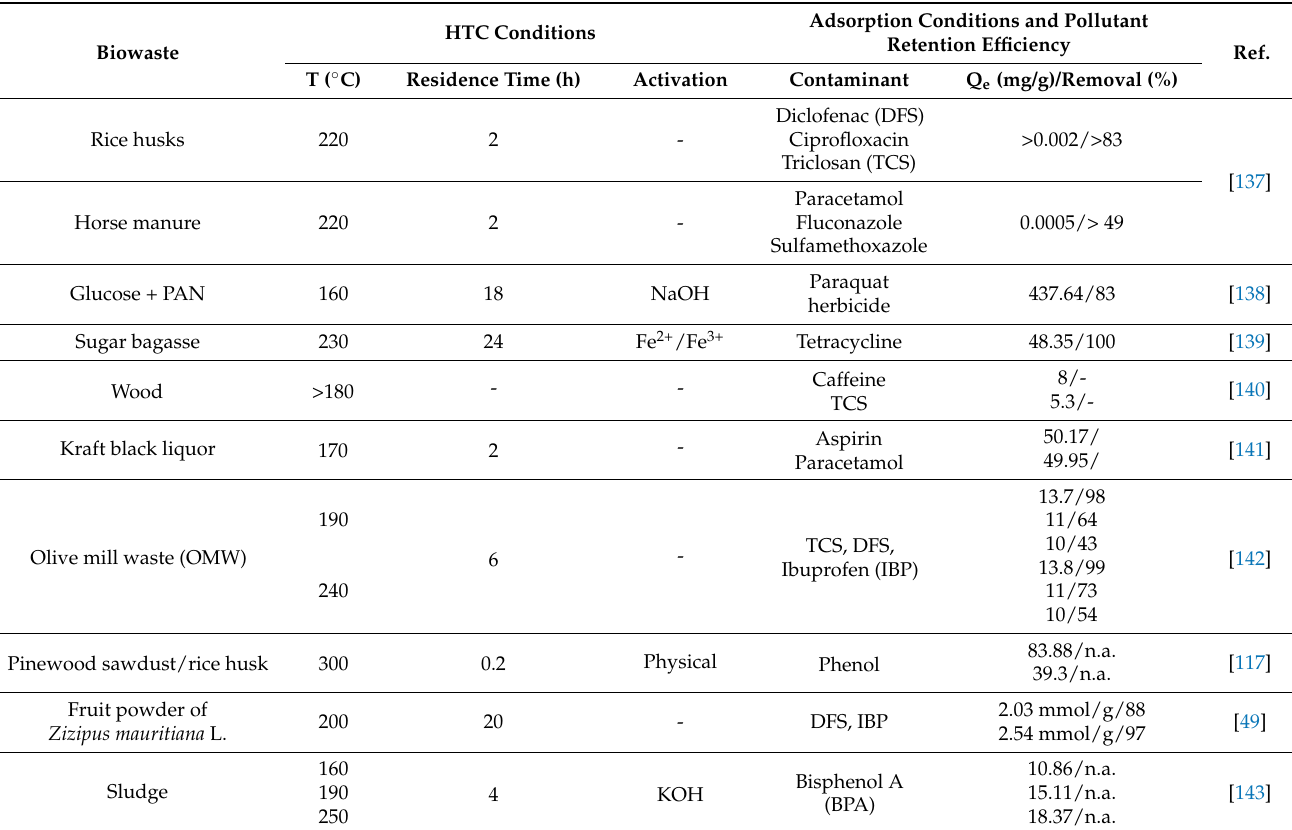
Table 2. HTC conditions and adsorption performance of HCs for EP removal from